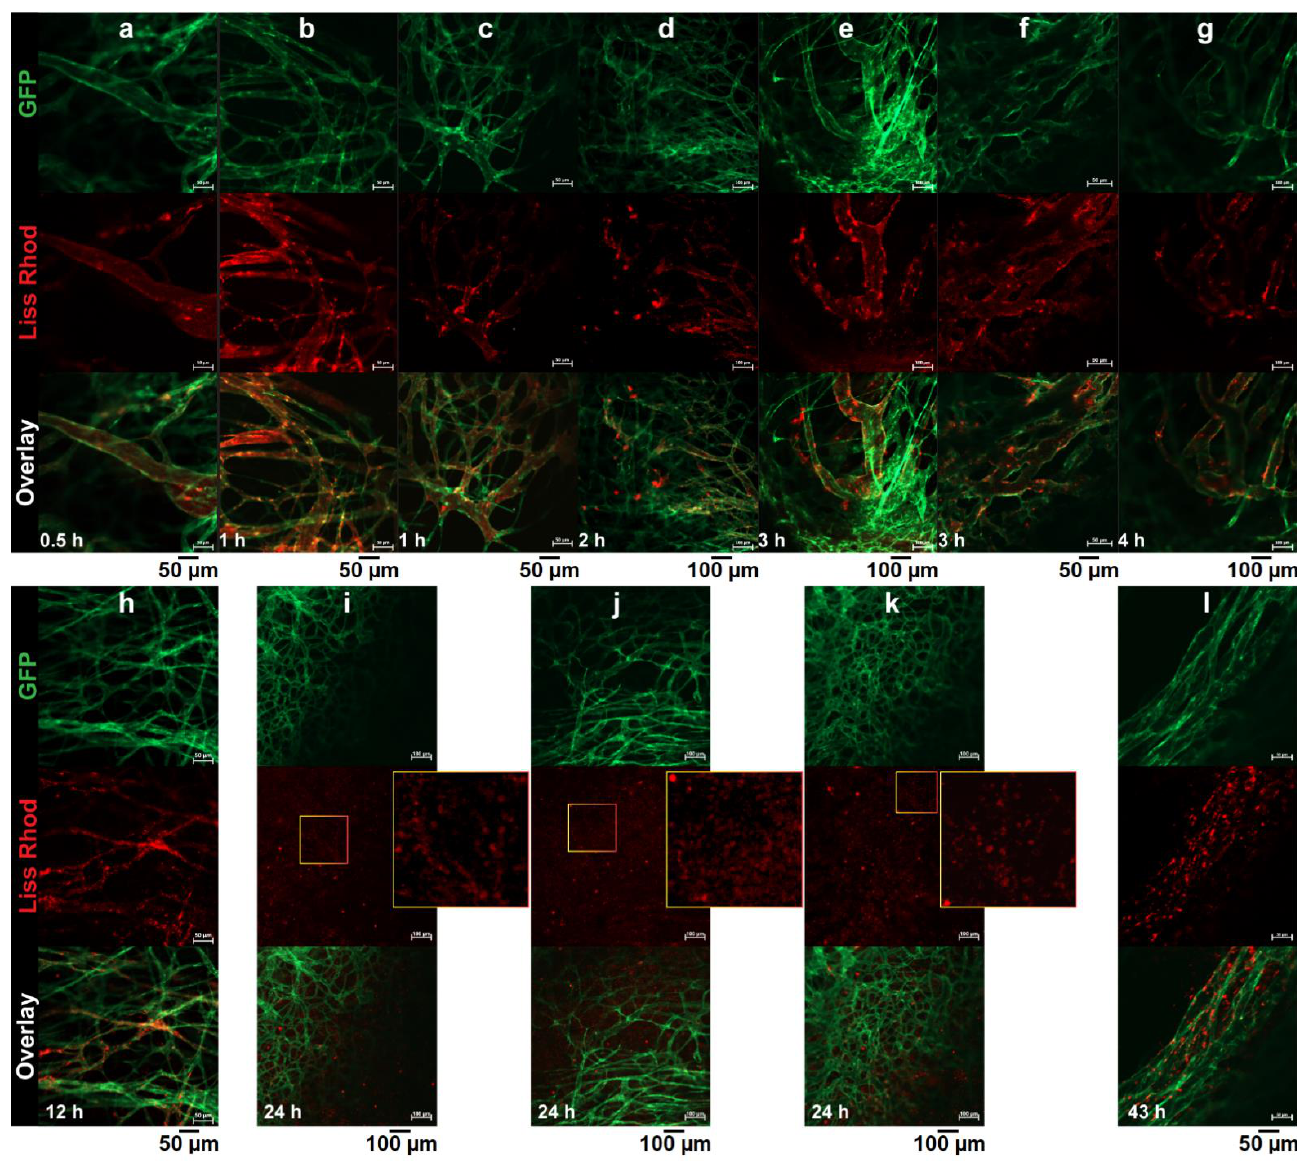
Figure 5. Intravital microscopy imaging of intratumoral behavior of Rho-PE-labeled (red) dually targeted liposomes (D32-FPL) in targeting tumor vasculature ( a – h ) or in extravascular association with cells ( i – l ) inside B16F0 tumors using the dorsal skin-fold chamber upon an IV injection of 5 μmol of liposomal lipids. Images were captured at different time points after injection. Green fluorescence of endothelial cells due to eNOStag-GFP expression.